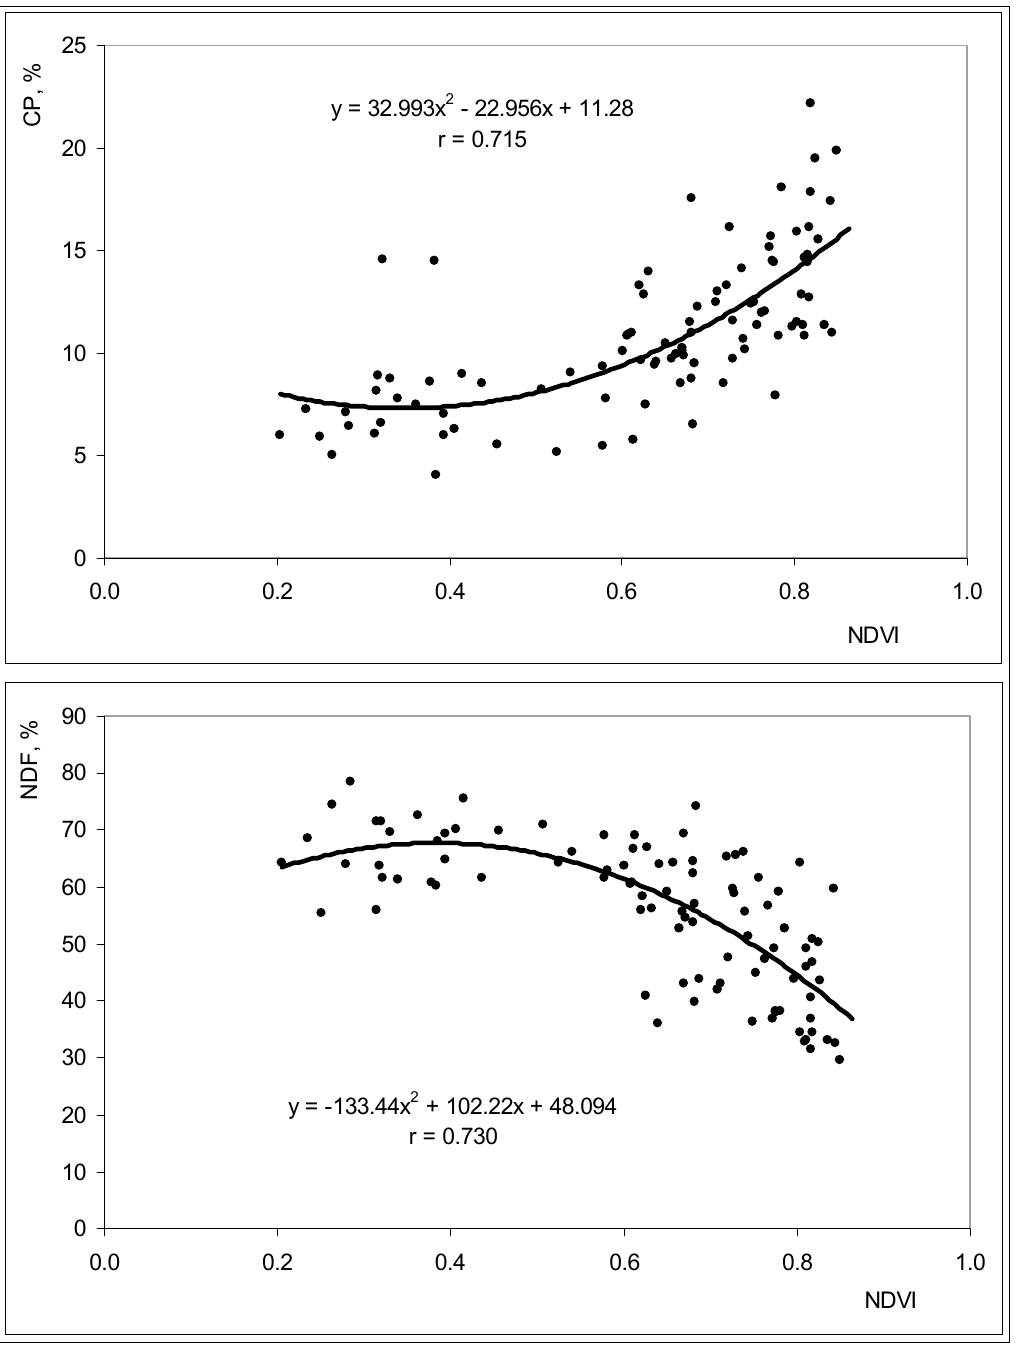
Figure 20. Relationship between NDVI measured by active optical sensor “OptRx TM ” and pasture crude protein (CP) and neutral detergent fibre (NDF) between March and June 2016, in all the twenty four sampling points.